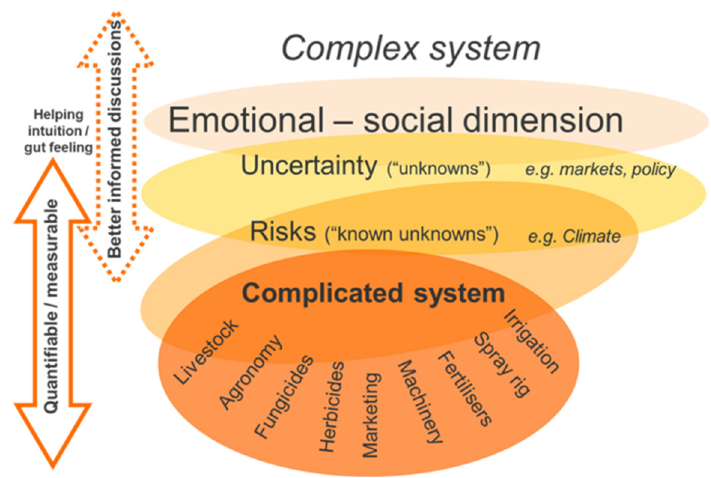
Figure 1. Conceptualization of the complexities in the management of a farm business and its disaggregation into quantifiable or measurable components, and the social-human dimension accessible via discussion, reflexion, and